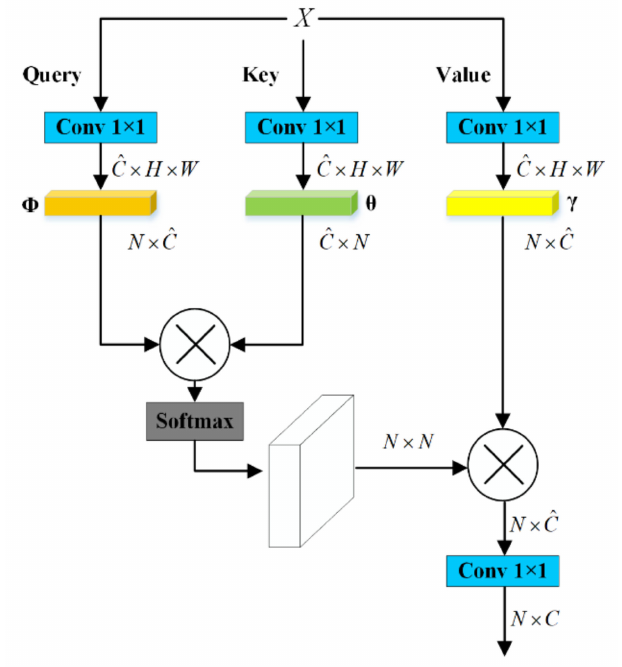
Figure 1. Non-local